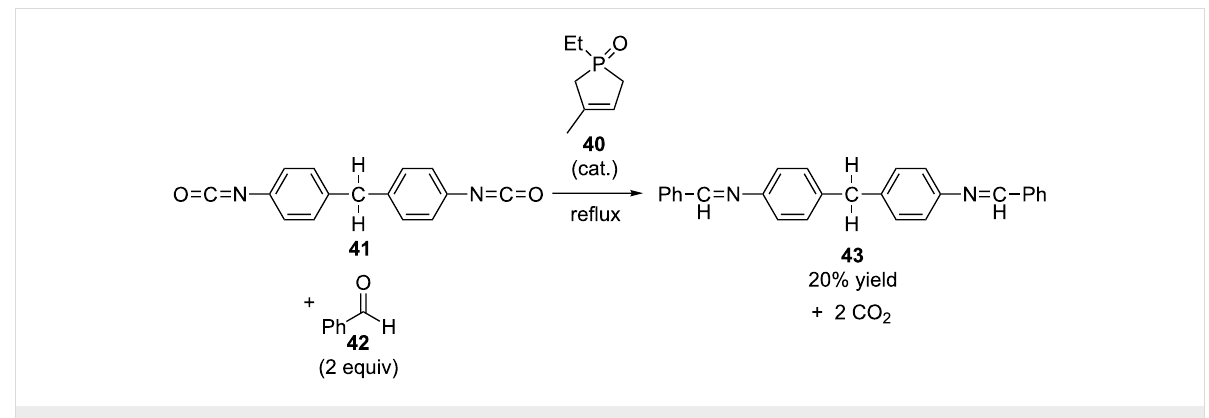
Scheme 13: First catalytic aza-Wittig reaction reported by